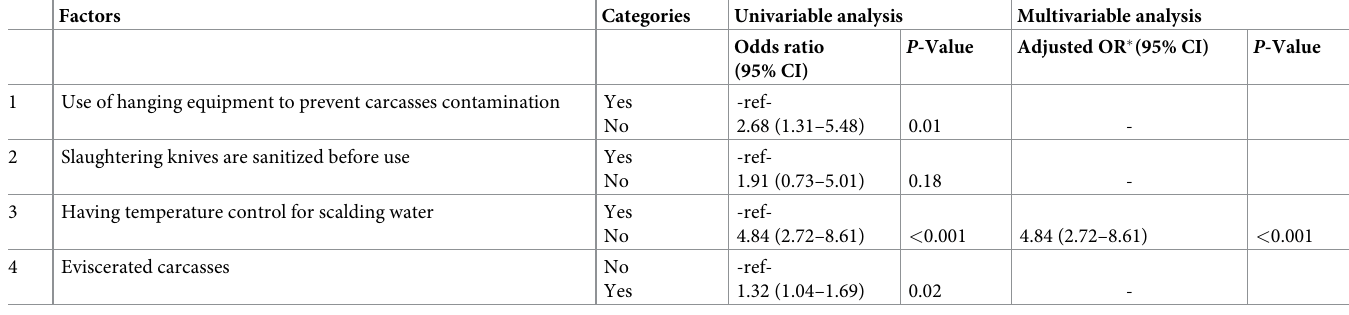
cess increased the risk for APC (Table 2), S . aureus (Table 3), Enterococcus spp. (Table 4), Table 2. Factors associated with the aerobic plate count non-compliance of meat samples based on the univariable and multivariable mixed-effects logistic regression.